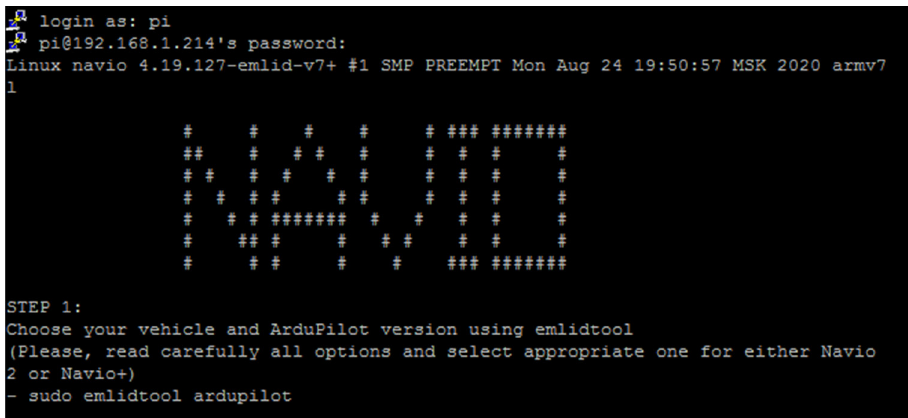
Figure 7. Launch of ArduPilot through the Navio2 controller .